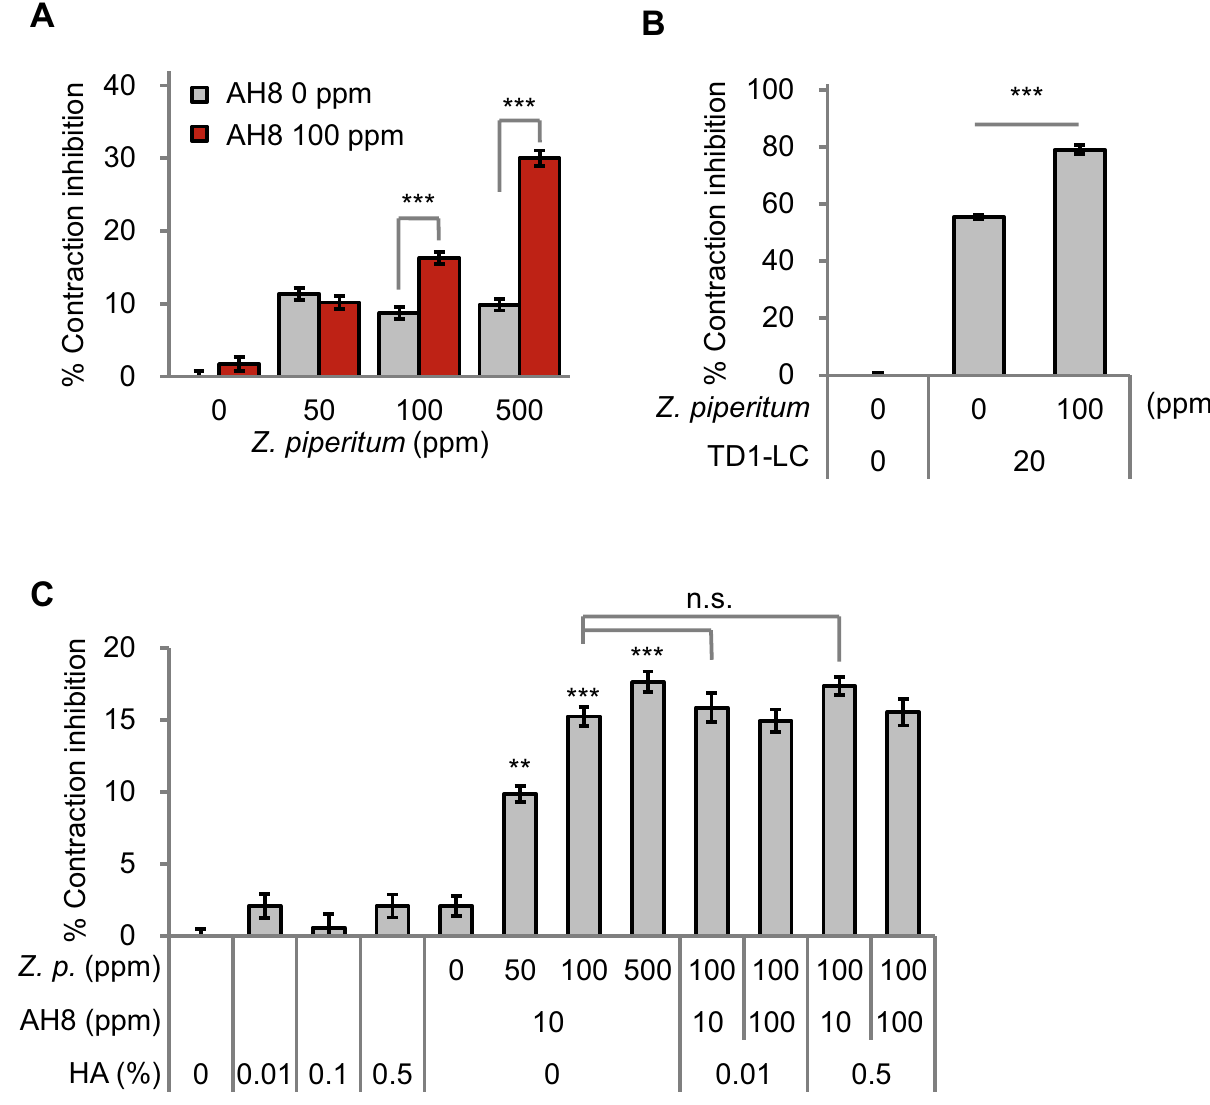
Figure 3. Synergistic effects of Z. piperitum extract and BoNT-like ingredients on muscle contraction inhibition. ( A and B ) Z. piperitum extract treatment synergistically inhibited muscle contraction with acetyl hexapeptide-8 (AH8) ( A ) and TD1-BoNT/A LC (TD1-LC) ( B ). ( C ) Muscle contraction inhibitory effects of the combination of Z. piperitum extract ( Z. p. ), acetyl hexapeptide-8 (AH8), and hyaluronic acids (HA). All the assays were performed at least twice. Error bars represent standard error of mean (S.E.M., n.s. not-significant, * p < 0.05, ** p < 0.01, *** p < 0.001, two ‐ tailed Student’s t ‐